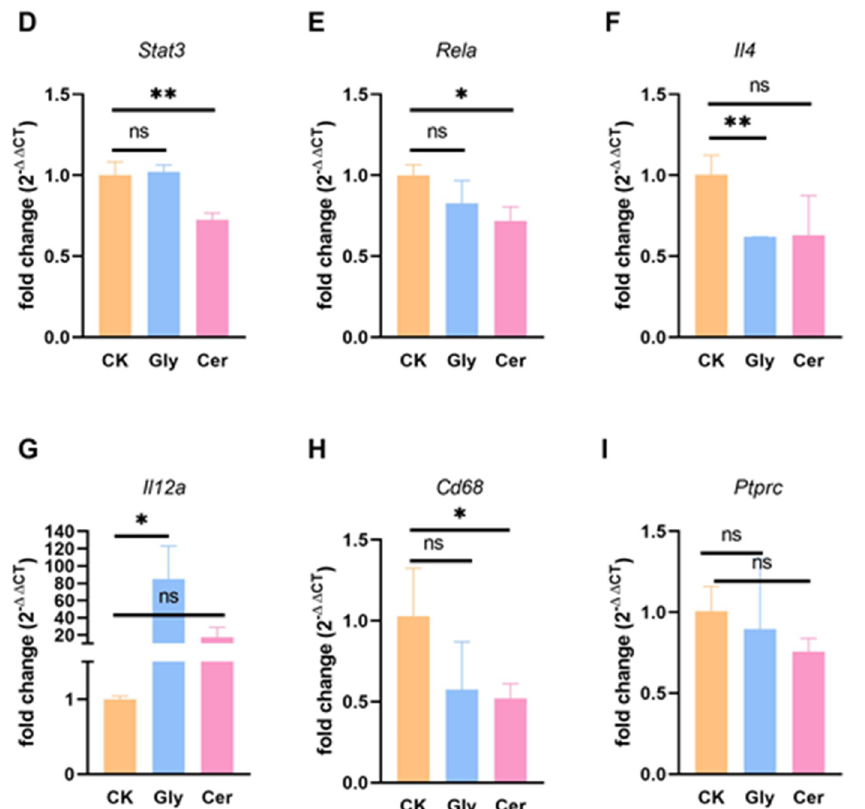
Figure 8. Effects of glyceryl trioleate and C16 ceramide treatment on the expression of Prkcg ( A ), Pik3r1 ( B ), Akt1 ( C ), Stat3 ( D ), Rela ( E ), Il4 ( F ), Il12a ( G ), Cd68 ( H ), and Ptprc ( I ) in DC2.4. DC2.4 was treated with glyceryl trioleate (500 µ M) or C16 ceramide (20 µ M) for 24 h, and then the expression of Prkcg , Pik3r1 , Akt1 , Stat3 , Rela , Il4 , Il12a , Cd68 , and Ptprc were detected by RT-qPCR. *, p < 0.05; **, p < 0.01; ns, no significance. CK, control group; Gly, glyceryl trioleate treated group; Cer, C16 ceramide treated group. n = 3.